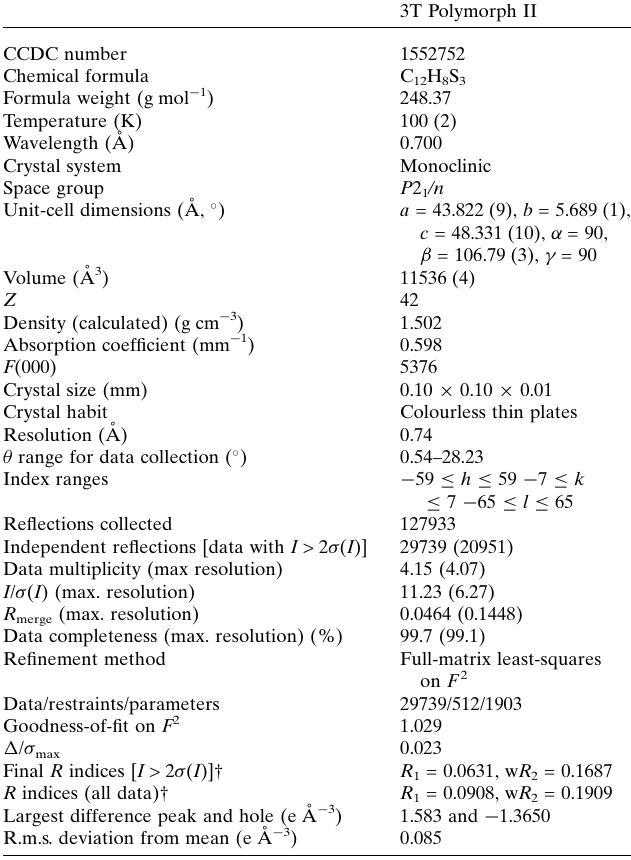
Table 1 Crystallographic information of the surface-confined polymorph of terthiophene.